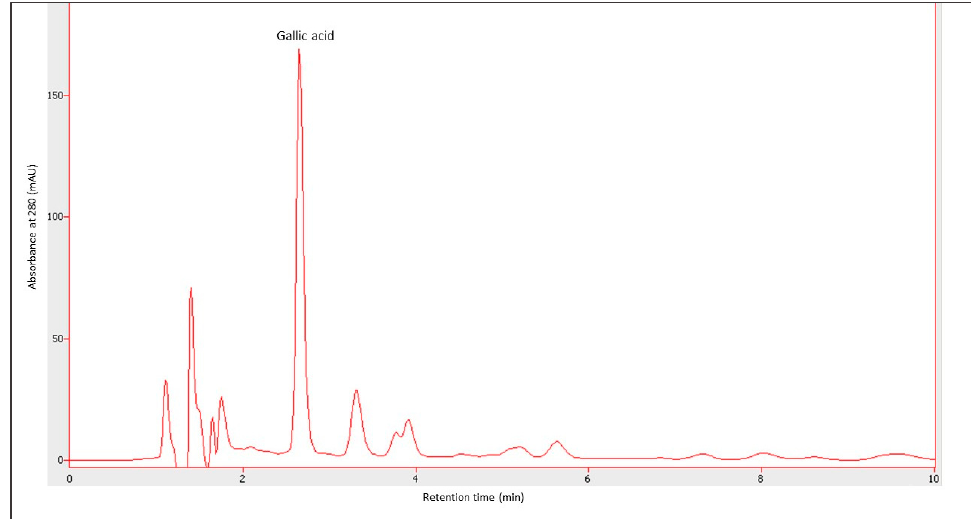
Figure 9. An example of a chromatogram for the determination of gallic acid. A sample of plum nalewka from 2019, the sample was diluted 100 times. The retention time of gallic acid was 2.650 min.